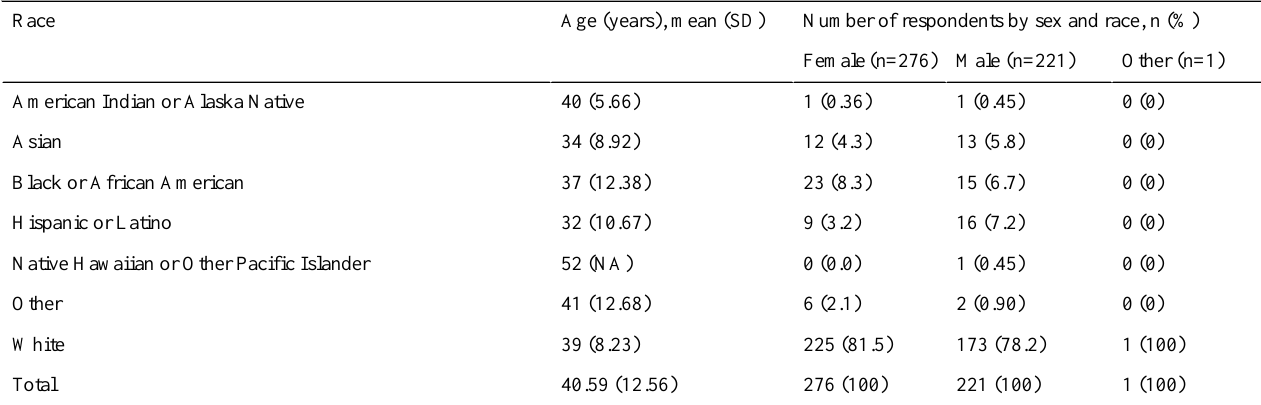
Table 2. Age, sex, and race distributions of the survey